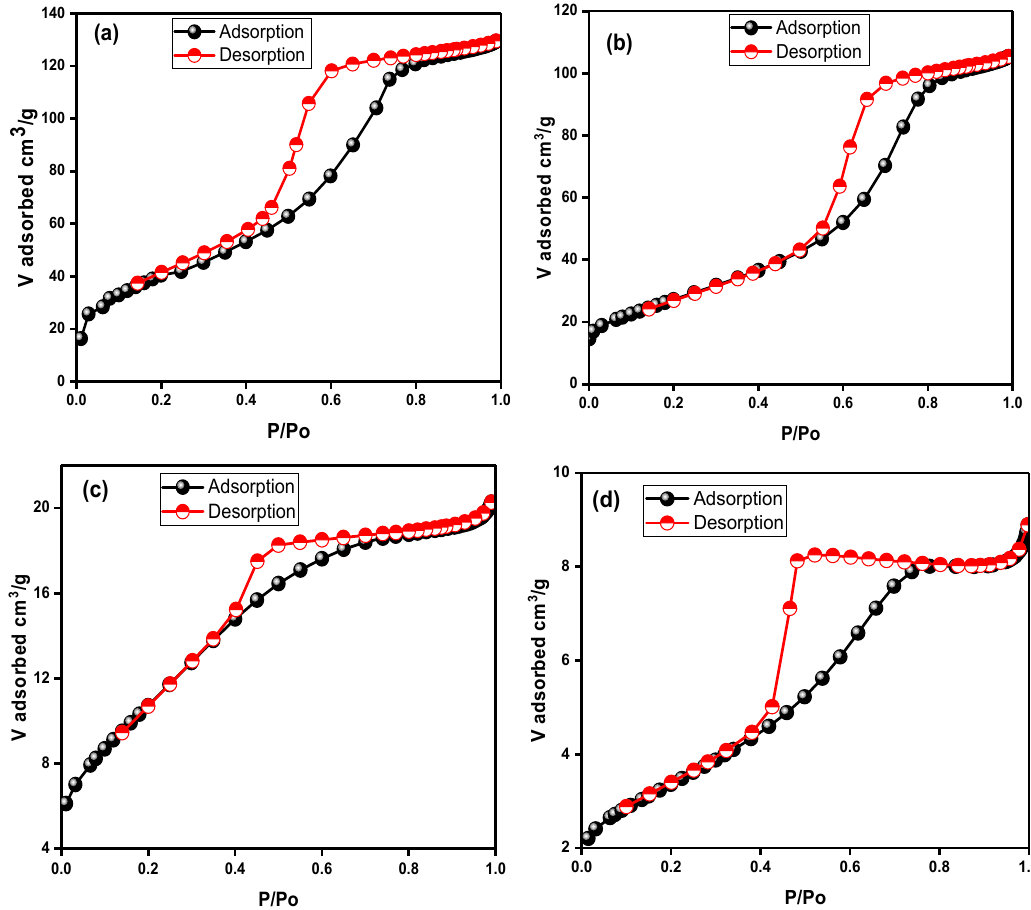
Figure 4. N 2 adsorption–desorption isotherms of colored TiO 2 prepared at various glycerol Figure concentrations and calcined at 300 °C ( a ) T1, ( b ) T2, ( c ) T3, and ( d ) T4.